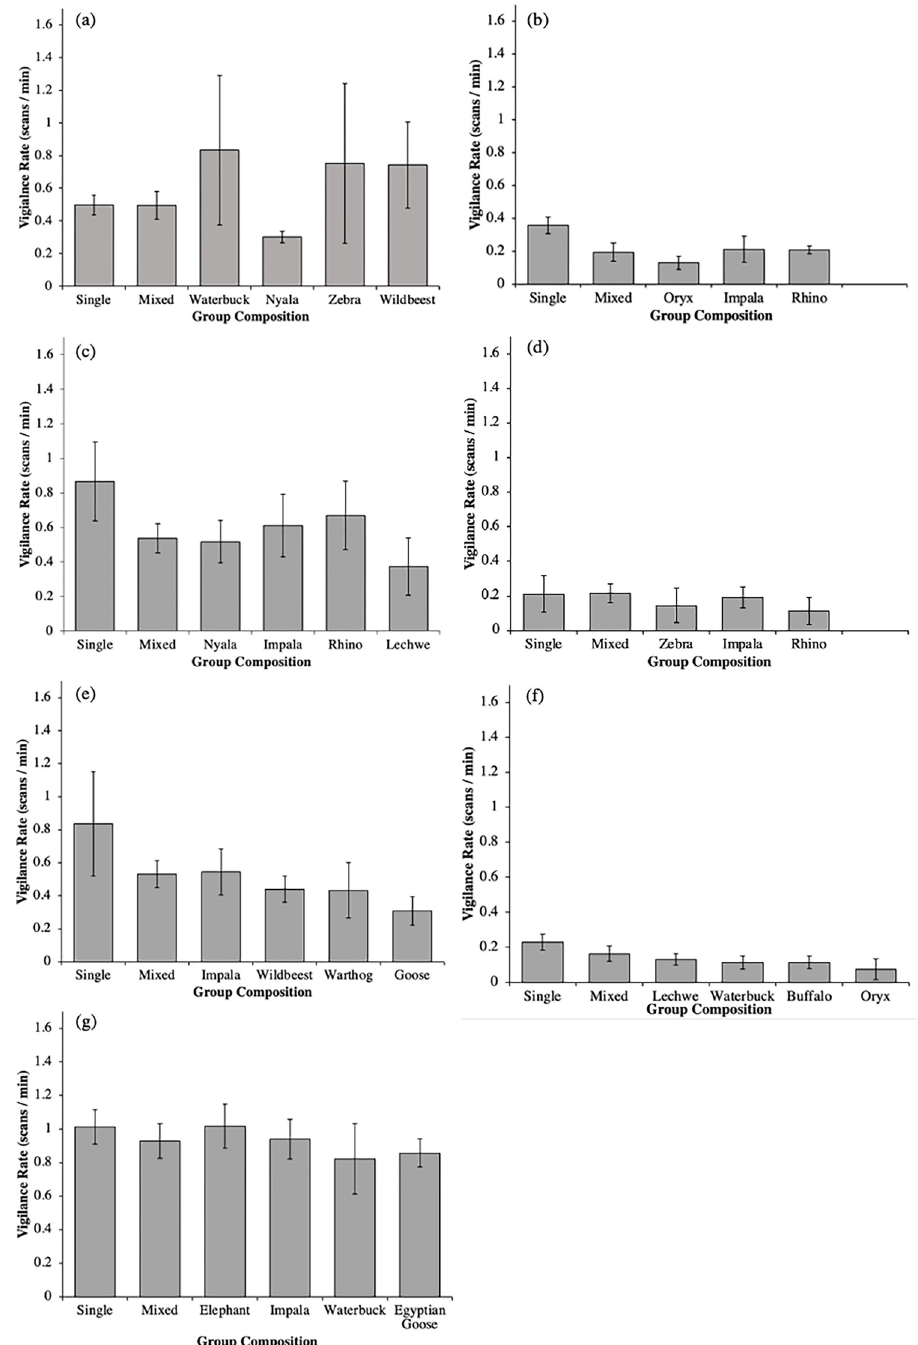
Fig 3. Rate of vigilance of (a) Impala (b) Giraffe (c) Defassa waterbuck (d) Wildebeest (e) Zebra (f) White rhinoceros and (g) Nyala, when in single and mixed species groups, or in the presence of another particular species.